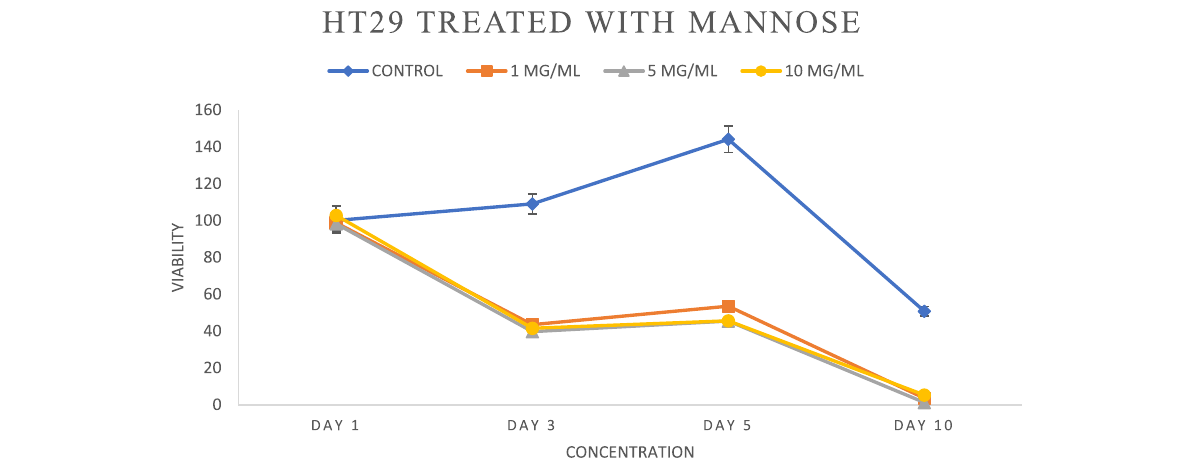
Fig. 3 The percentage of HT29 cells when treated with mannose at 1 mg/ml, 5 mg/ml and 10 mg/ml for three period of times; day 1, day 3, day 5 and day 10 ( p value <